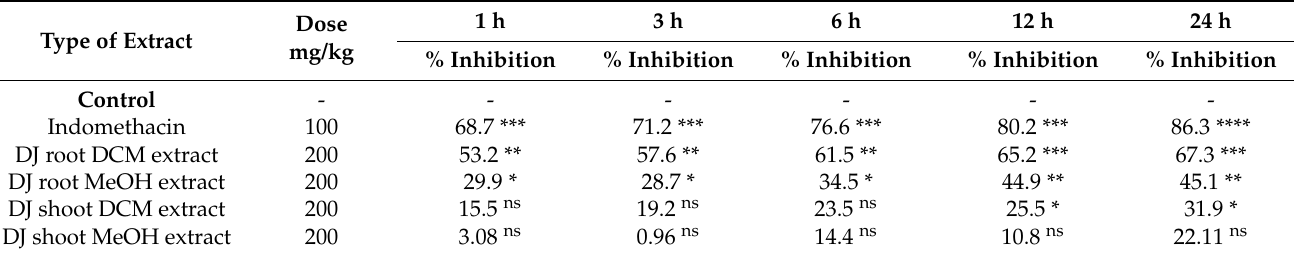
Table 3. Formaldehyde-induced edema in mouse hind